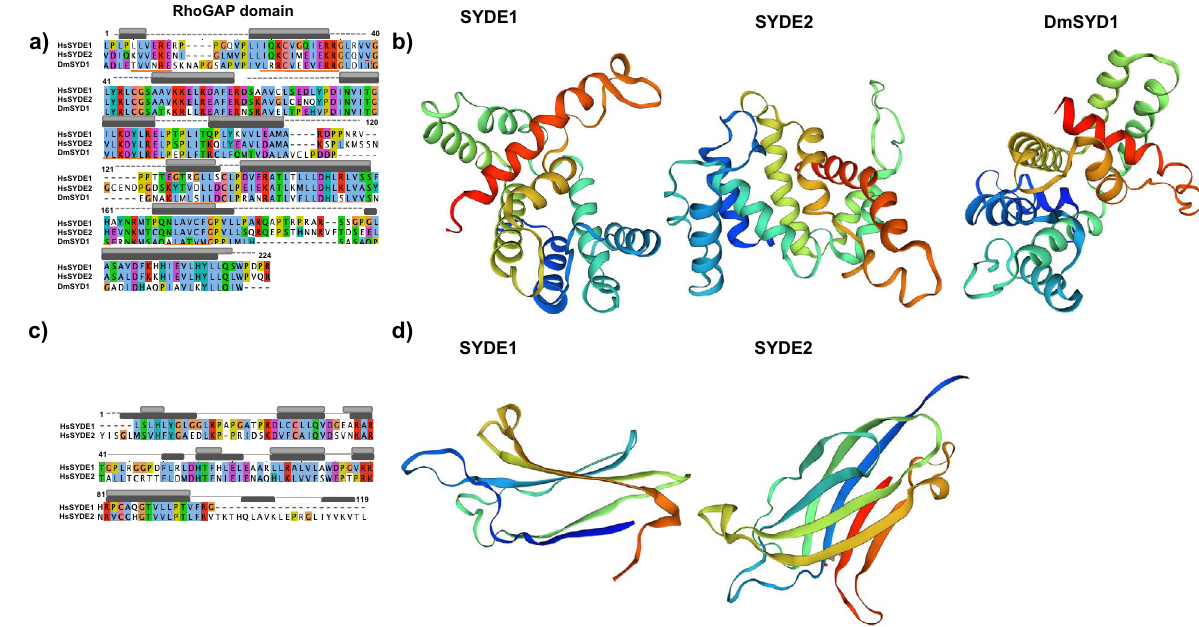
Figure 4. Overview of SYDE RhoGAP domains and structural RhoGAP models. ( a ) Consensus sequences of SYDE1 RhoGAP domains are shown in the panels. Secondary structures of human SYDE1 are indicated above the sequences (α-helix: gray column for SYDE1 and dark gray column for SYDE2; coiled-coil: gray dotted line) and α-helix of DmSyd1 is represented by horizonal orange line below the sequences. ( b ) Cartoons of SYDE RhoGAP domains are colored from the N-terminus (blue) to C-terminus (red). ( c ) Consensus sequences of SYDE C2 domains and secondary structures of human SYDE1/2 used for structure prediction are indicated above the sequences (β-sheet: gray column for SYDE1 and dark gray column for SYDE2). ( d ) Structure of SYDE C2 domains are colored from the N-terminus (blue) to C-terminus (red) by UCSF Chimera. The three- dimensional structures were visualized using UCSF Chimera software version 1.15 (http:// www. cgl. ucsf. edu/ chime ra).